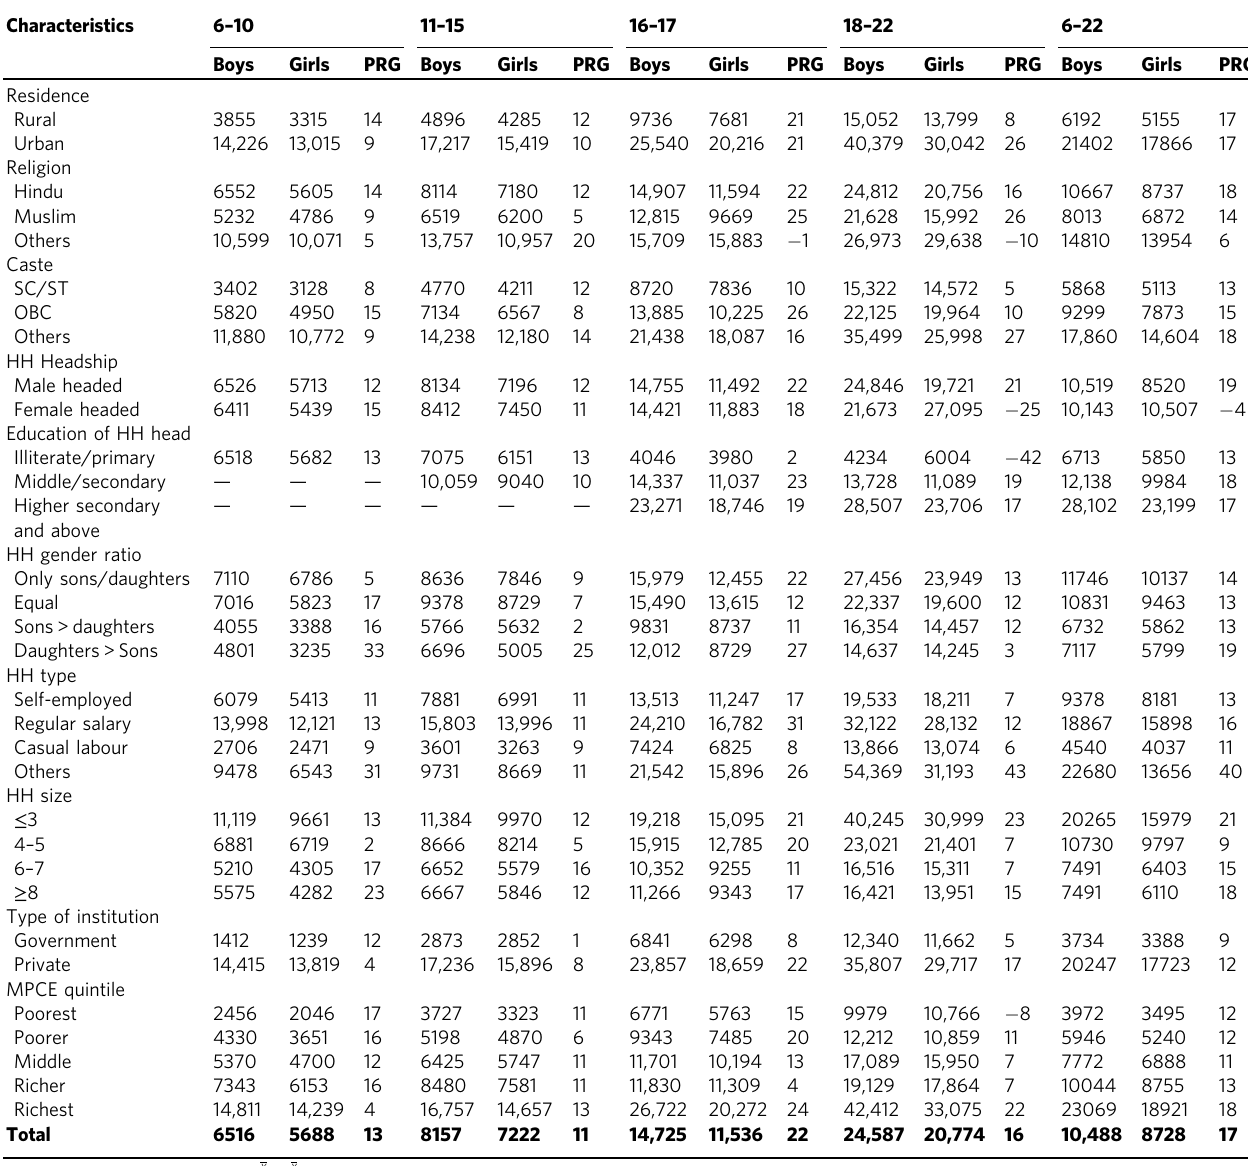
Table 3 Per capita educational spending (in Indian Rupees.) during the current academic year of basic courses by gender and background characteristics in 6 – 22 age groups of India, 2017 –